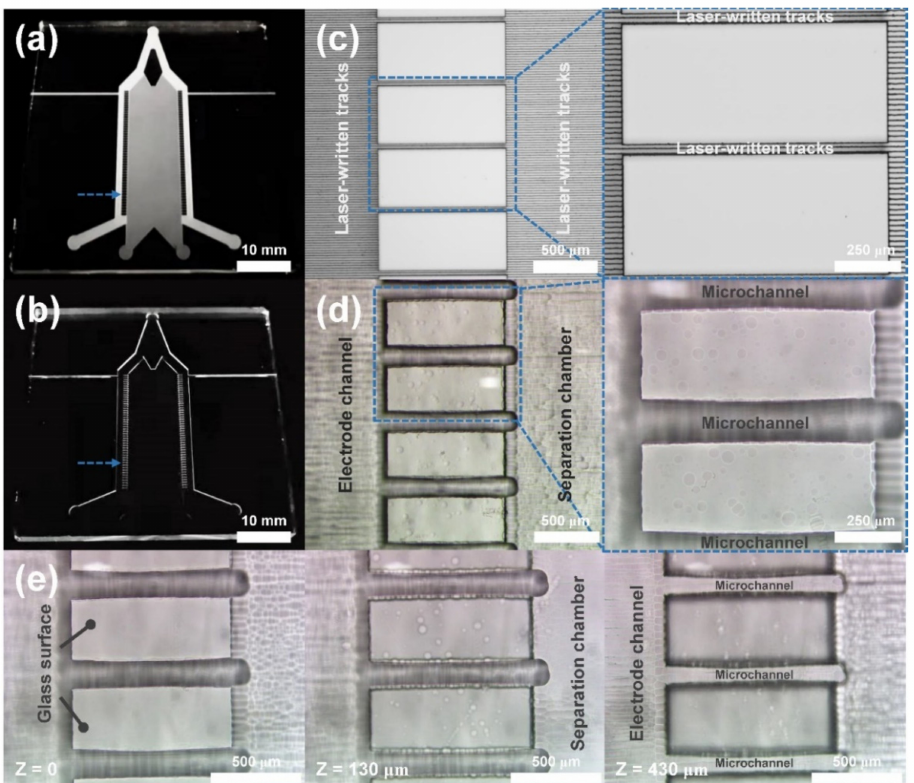
Figure 2. Photos of fs-laser-processed fused silica bottom plates ( a ) before and ( b ) after chemical etching. Optical microscope images of the laser-processed microstructures ( c ) before and ( d ) after chemical etching as indicated by dashed arrows in ( a , b ), respectively. Insets in ( c , d ) show close-up images of the dashed rectangular areas in ( c , d ), respectively. ( e ) Optical microscope images of the etched microstructures at different focal positions. Left: the glass surface; Middle: the bottom surface of the separation chamber; Right: the bottom surface of the electrode channel and